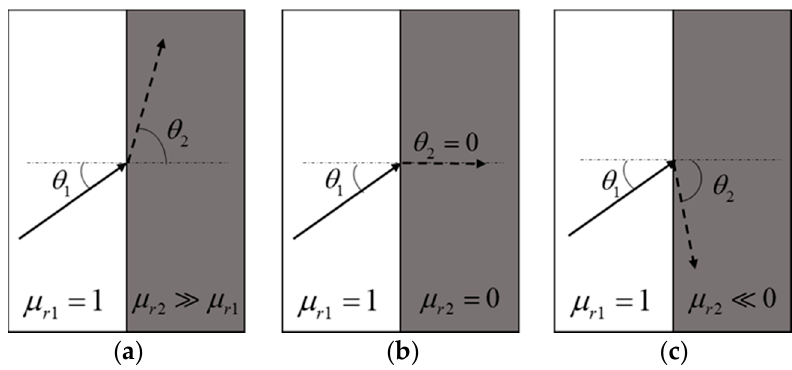
Figure 6. Reflection principle of electromagnetic waves. ( a ) High positive μ r2 . ( b ) Zero μ r2 . ( c ) High negative μ r2 .